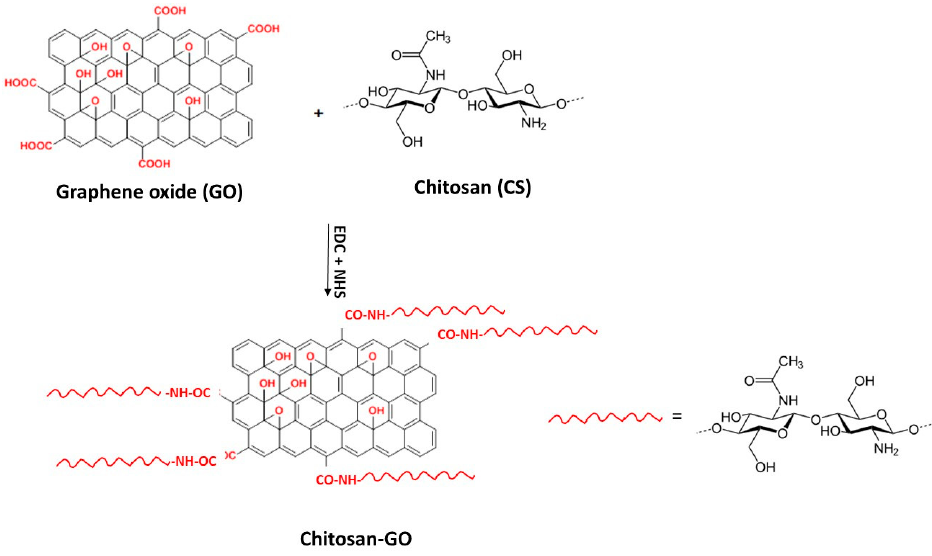
Figure 4. Scheme of Chitosan-GO amidation reaction.